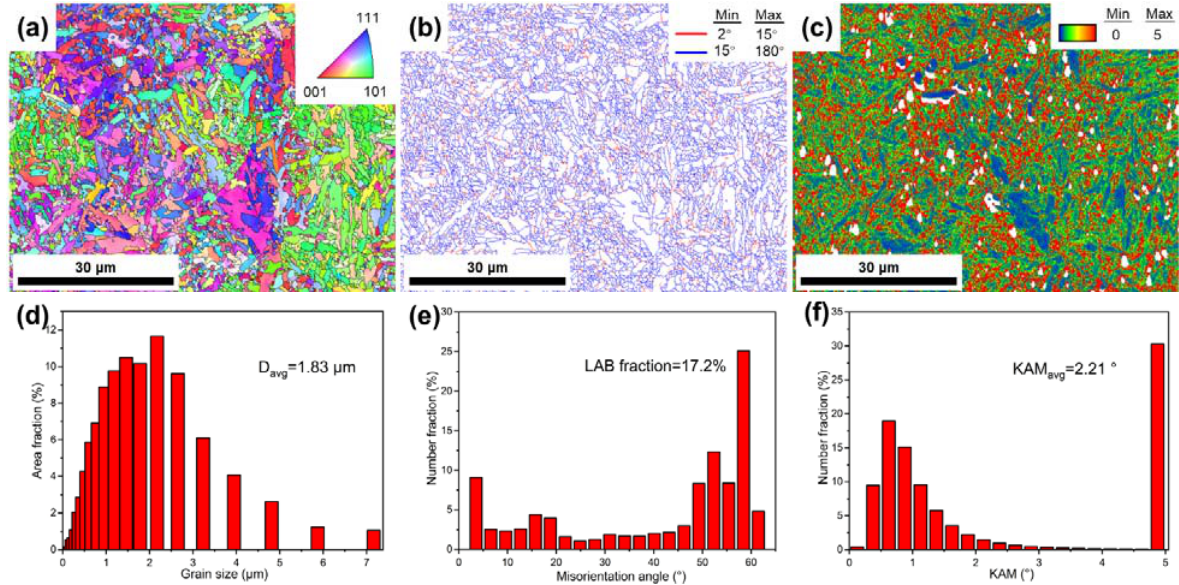
Figure 1. EBSD results of M50 matrix after QT heat treatment: ( a ) IPF map; ( b ) grain boundary map; ( c ) KAM map; ( d – f ) statistical results of ( a –c), respectively.